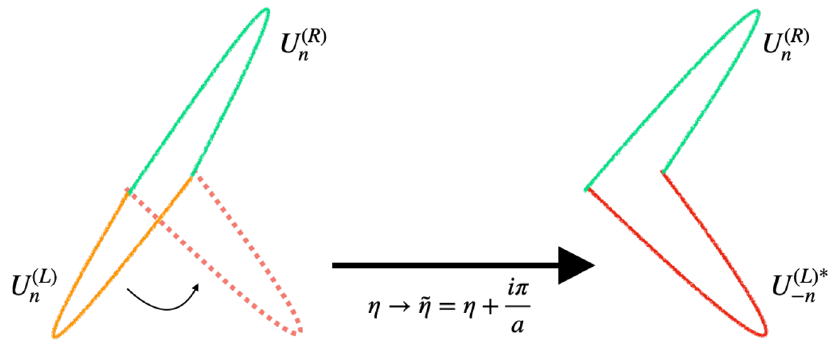
Figure 8 . A visual representation of defining global modes of the accelerated string. Here the green and orange segments are on a constant η slice, hence an actual ‘closed’ string. An analytical continuation on Rindler time maps the orange segment into the red one, projecting it into the Right Rindler string. This combination of modes are globally